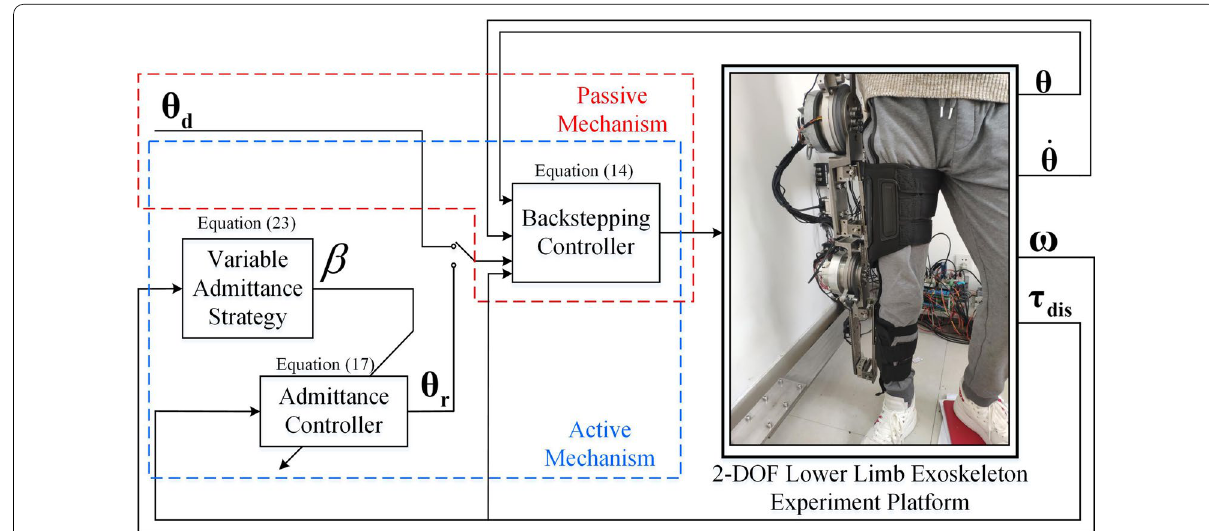
Figure 1 Control scheme of lower limb exoskeleton in active model and passive mode